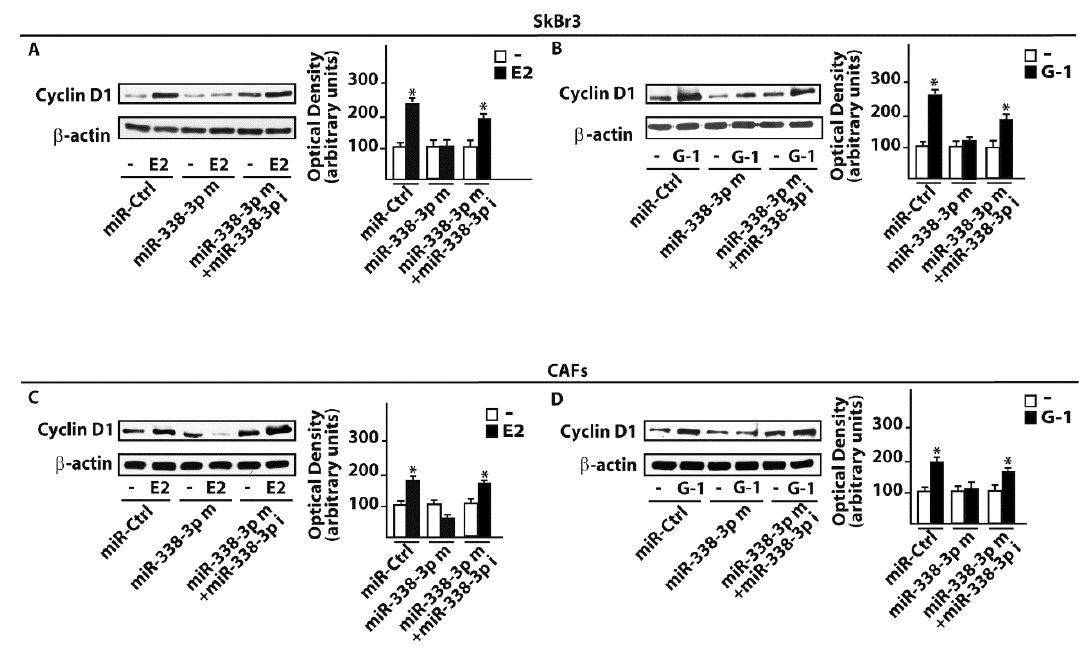
Figure 8. miR-338-3p prevents Cyclin D1 protein induction by E2 and G1 in SkBr3 cancer cells and CAFs. Cyclin D1 protein expression in SkBr3 cancer cells ( A , B ) and CAFs ( C , D ) transfected for 48 h with 25 nM miR-Ctrl or miR-338-3p mimic (miR-338-3p m) in combination or not with 50 nM miR-338-3p inhibitor (miR-338-3p i) before treatment for 12h with 100 nM E2 or 100 nM G-1. Side panels show densitometry analysis of the blots normalized to the loading control β -actin. (*) indicates p < 0.05 for cells receiving treatments vs cells treated with vehicle (-).